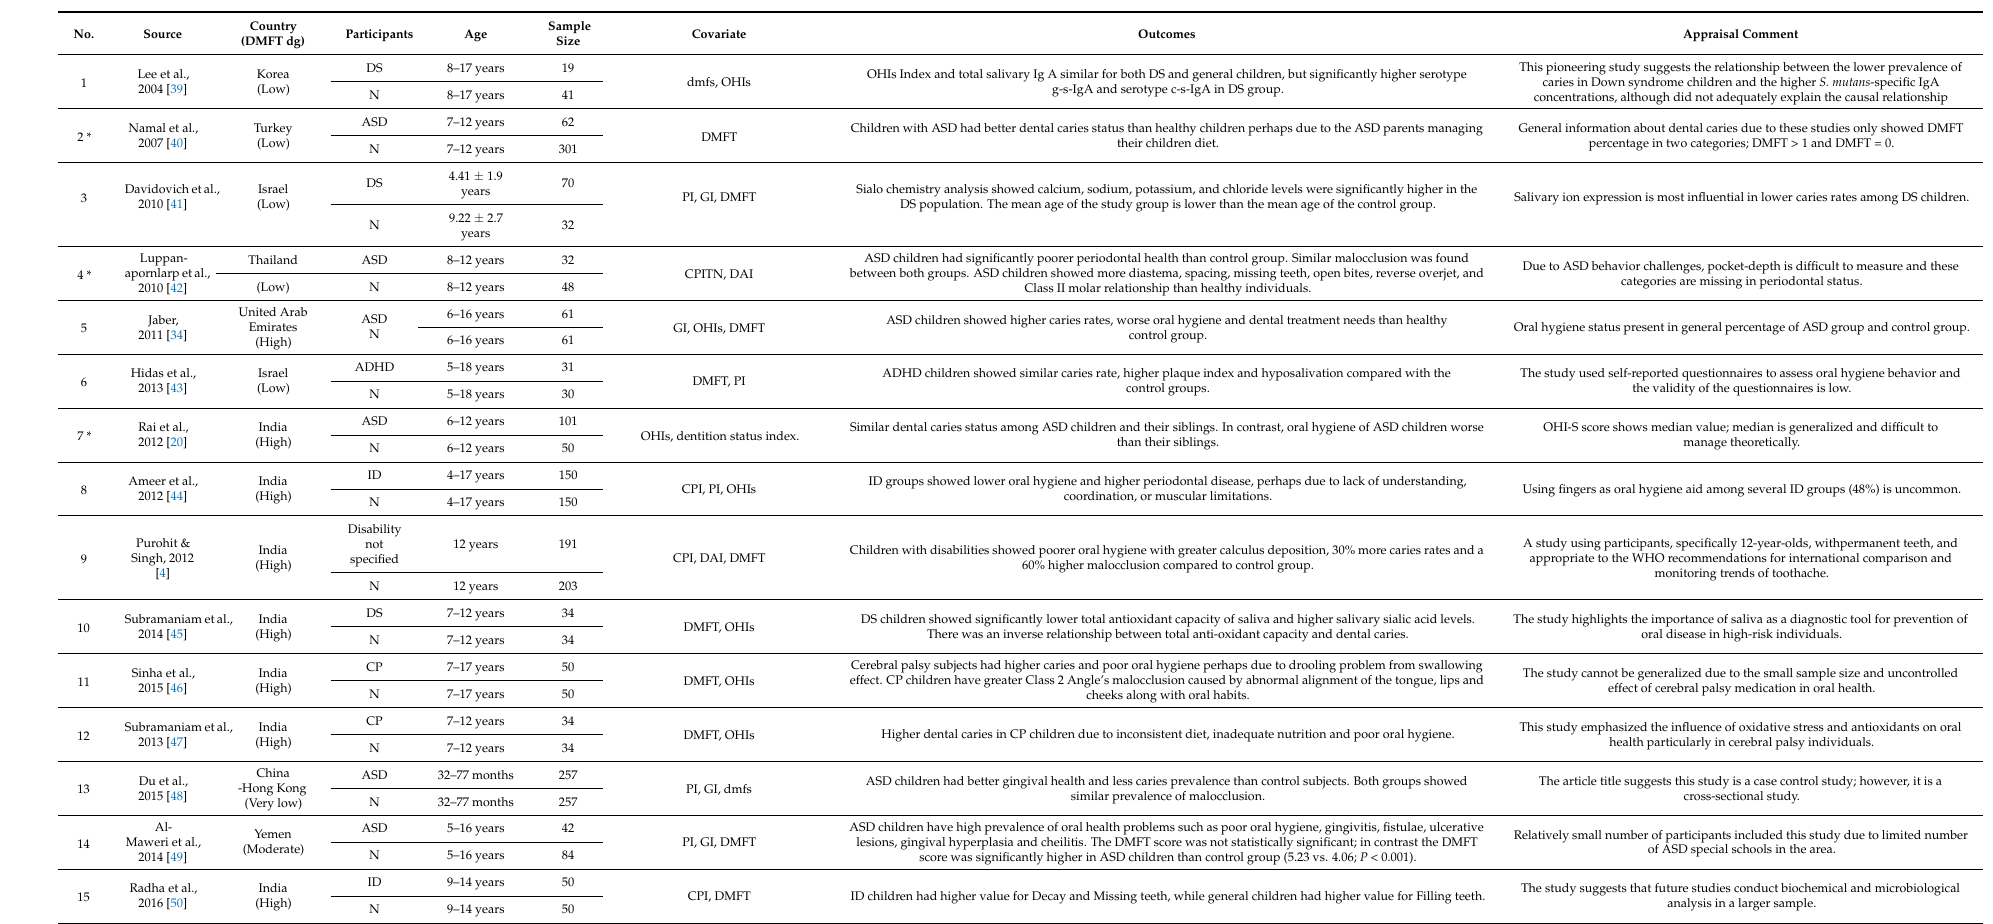
Table 1. The characteristics of the included